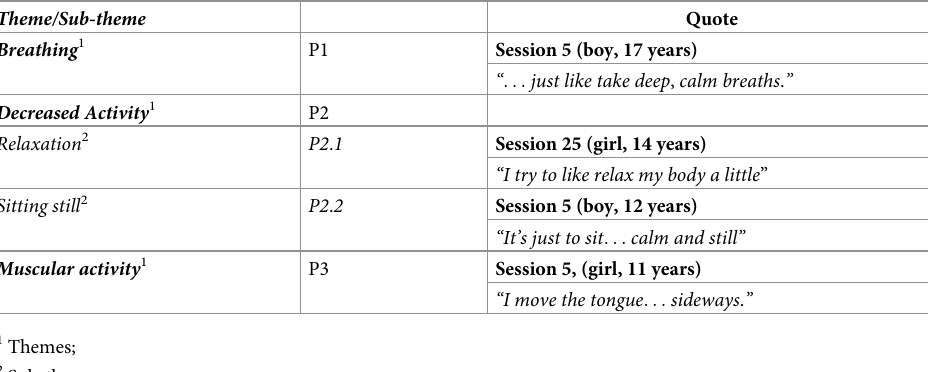
Table 4. Quotes on physiological strategies during slow cortical potential